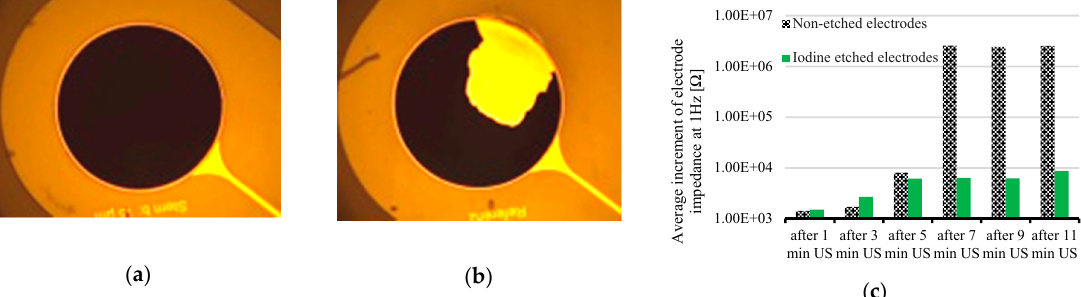
Figure 4. The condition of PEDOT:PSS coating: ( a ) iodine etched electrode after 11 min ultrasonic test; ( b ) non-etched electrode after 7 min ultrasonic test; ( c ) Average increment of electrode impedance during ultrasonic test of PEDOT:PSS (ultrasonic test abbreviated as US); non-etched electrode impedance increased 2.5 M Ω after 7 min ultrasonic